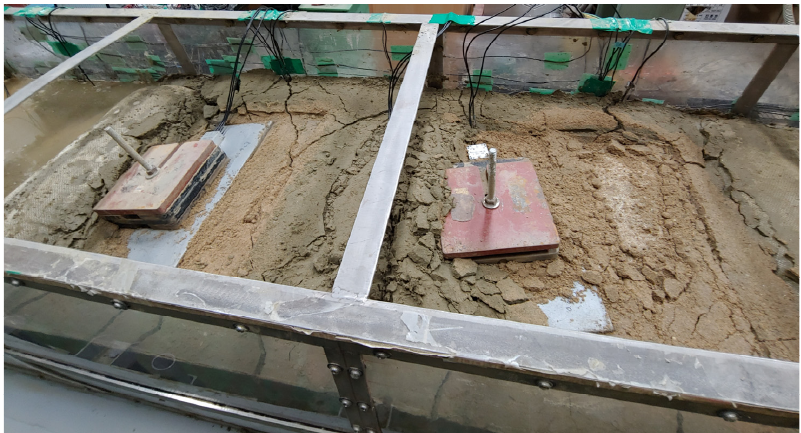
Figure 20. Photo of the scale model before and after the occurrence of lateral spreading and geotextile tube settlement: ( a ) t = 0 and ( b ) t = 225 s.